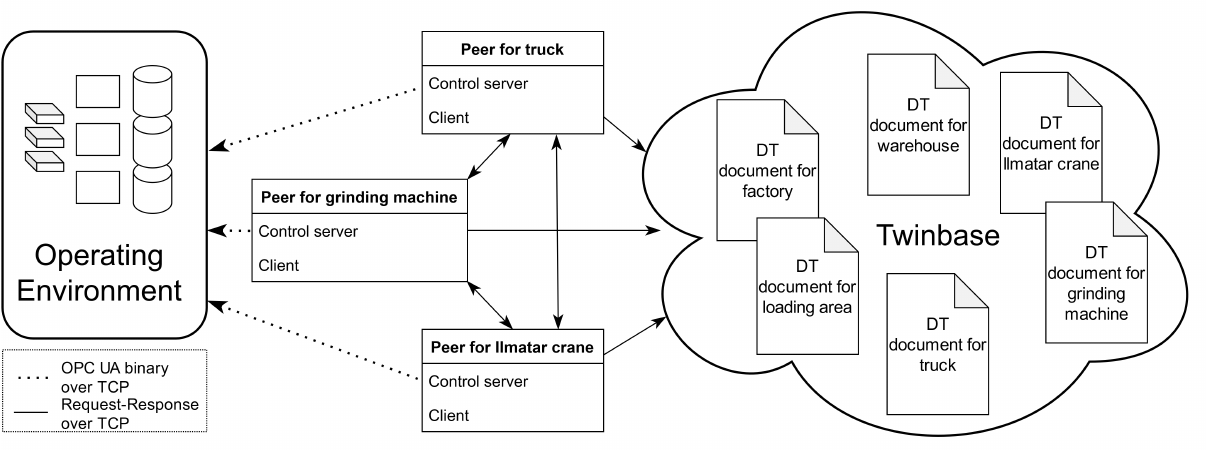
Figure 5. In the decentralized P2P control implementation, machines control the factory by commu- nicating with each other. The arrows indicate the direction in which communication can be initiated, but data can still flow in both